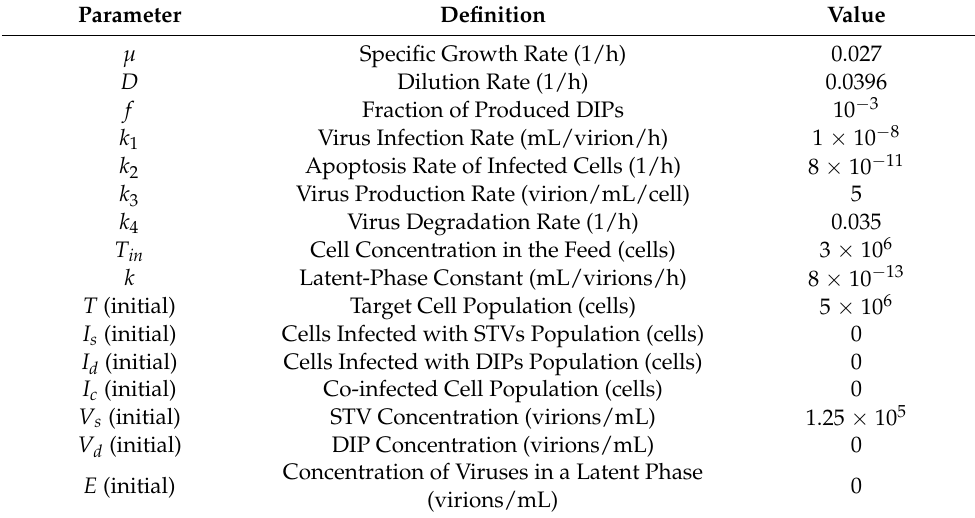
Table 1. Estimated model parameters and initial